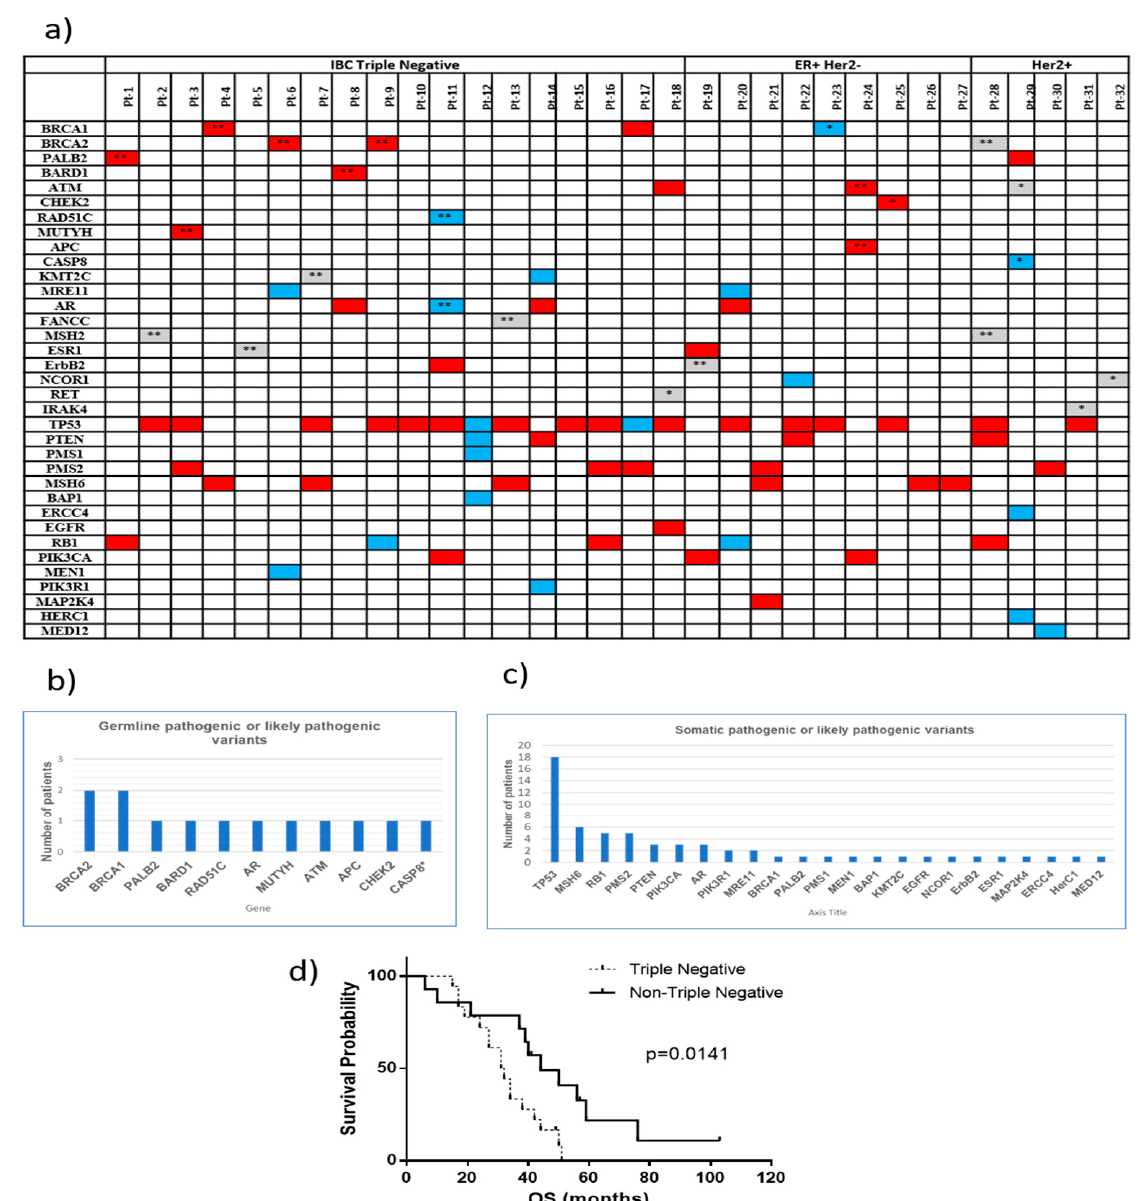
Figure 2. Genetic variants in IBC. ( a ) Germline and somatic variants detected in each patient. Pathogenic, likely pathogenic, and variants of uncertain significance, in red, blue, and grey, respectively. ** Confirmed germline variants by NGS of normal tissue or whole blood. * Putative germline variants; ( b ) Germline pathogenic and likely pathogenic variants; ( c ) Somatic pathogenic or likely pathogenic variants; ( d ) Kaplan–Meier curves for triple negative (TN) and non-TN. The median OS is 31.5 and 44 months for TN and non-TN, respectively.